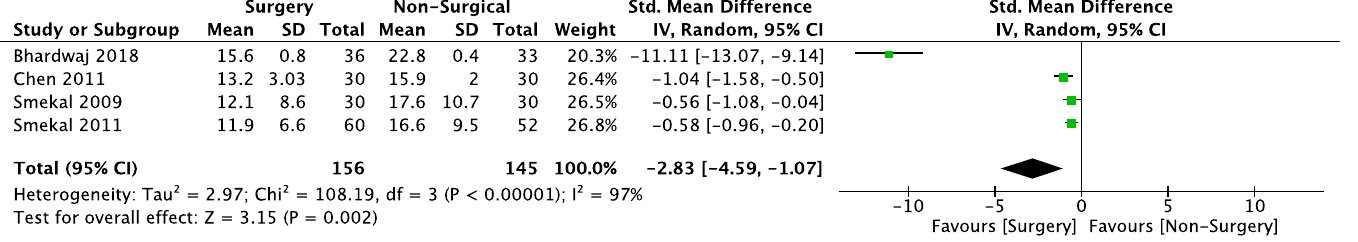
Fig 6. Meta-analysis of time to bony union between surgical and non-surgical intervention in pooled studies. Standard-mean difference is -2.83 (95% CI -4.59 to -1.07; p =